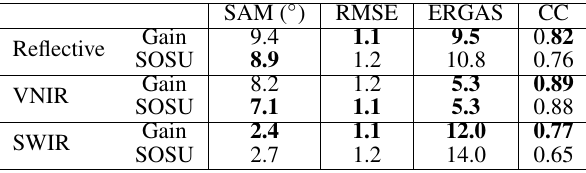
Table 4. Criteria computed on shadowed pixels result because shadowed areas represent not only a significant proportion of urban areas (here, 24 % of the image), but also a specific and challenging aspect of this type of scenes.